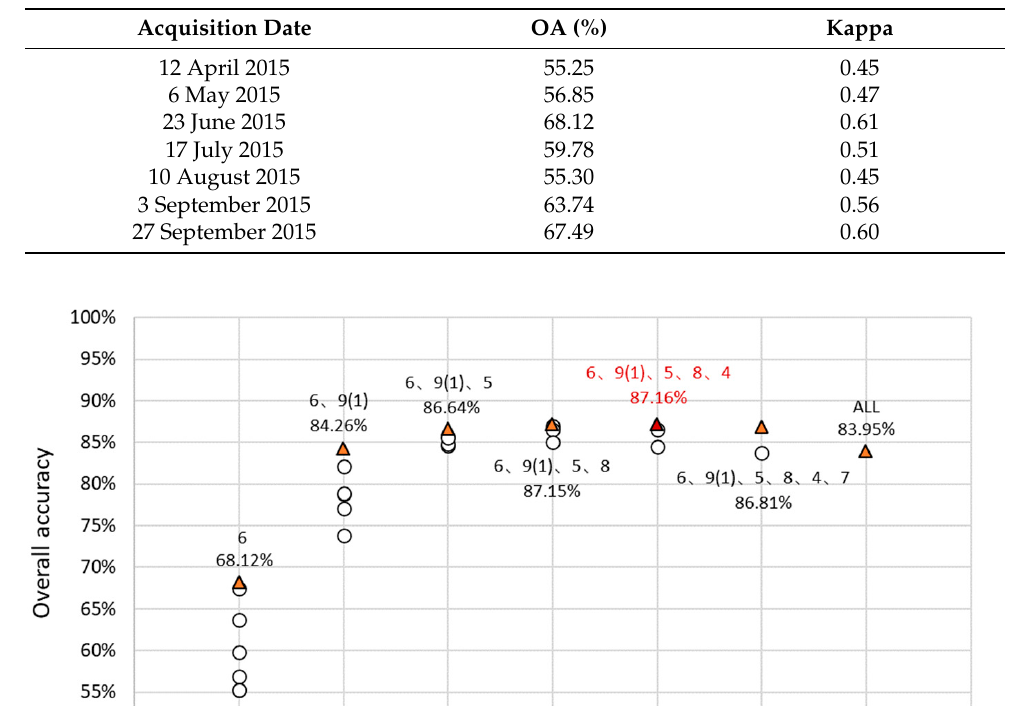
Figure 14. Classification map with the best accuracy simultaneously using optimal combination of polarimetric observables and images (OA = 94.04%).